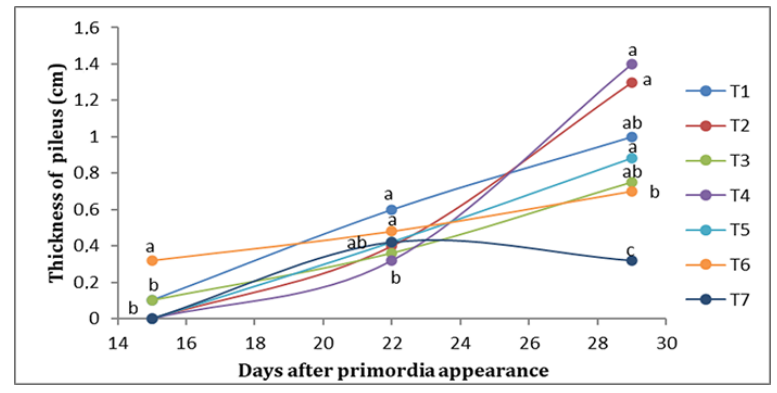
Figure 2 ickness profile of pileus as a function of time.